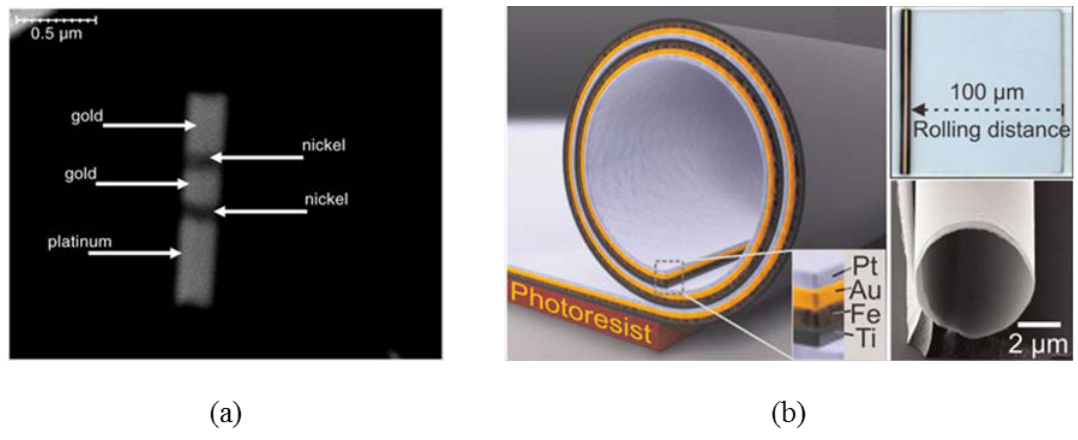
Figure 8. ( a ) Striped metallic nanorod 1.5 μm × 400 nm [32] and ( b ) Multi-metallic